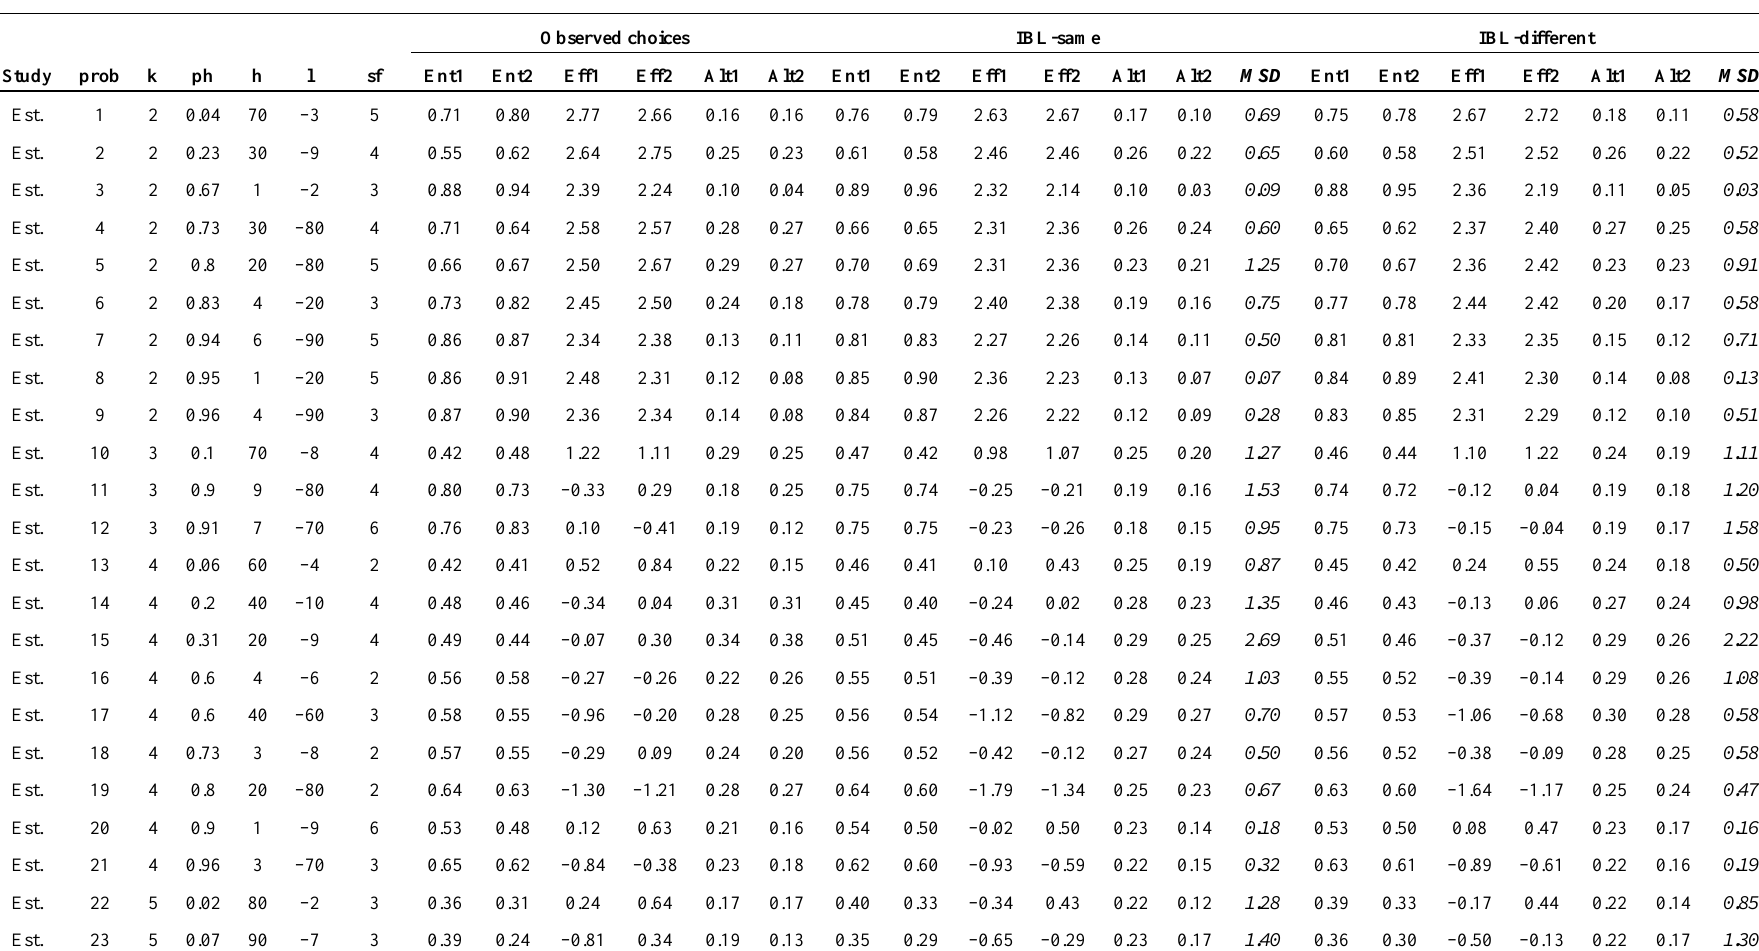
Table A1 . The 40 market entry games in the estimation set . Problem parameters, observed choice rates, and predictions by the IBL-same and